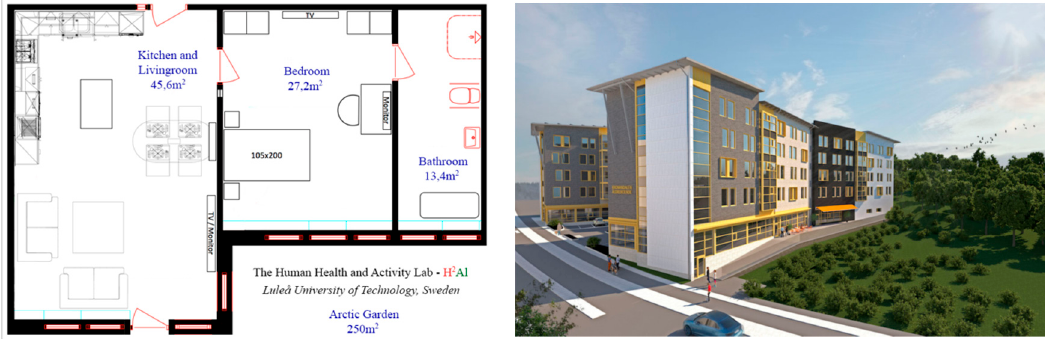
Figure 1. The Human Health and Activity Lab ( Left ) and Kronandalen Elder Care Facility ( Right